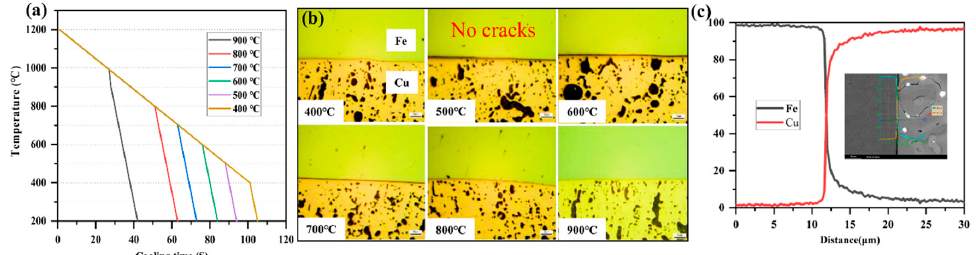
Figure 2. The bimetal rapid solidification test parameters and steel-copper interface. ( a ) Test parameters of the steel–copper bimetal; ( b ) OM microstructure; and ( c ) Fe–Cu atomic interdiffusion.